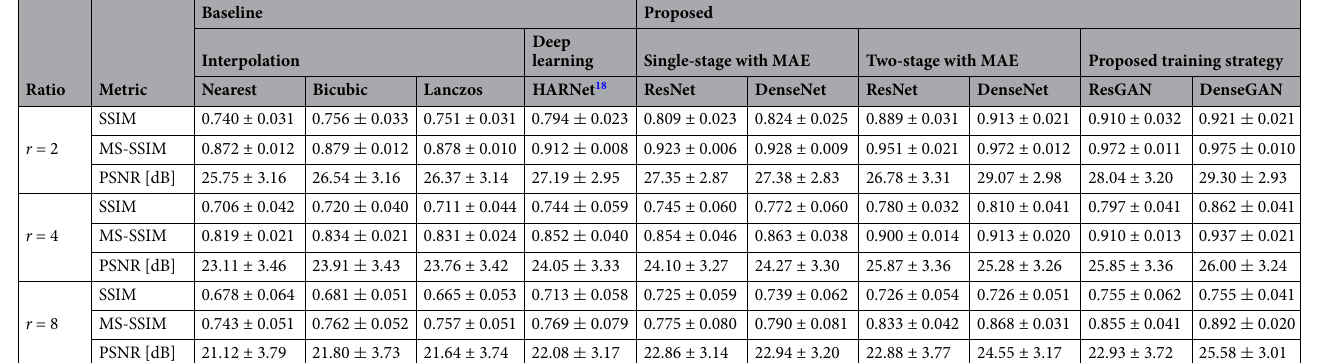
Table 2. Performance metrics of different methods evaluated on the test dataset composed of sectioned enface angiograms. Our deep learning models are denoted as ResNet, ResGAN, DenseNet, and DenseGAN in